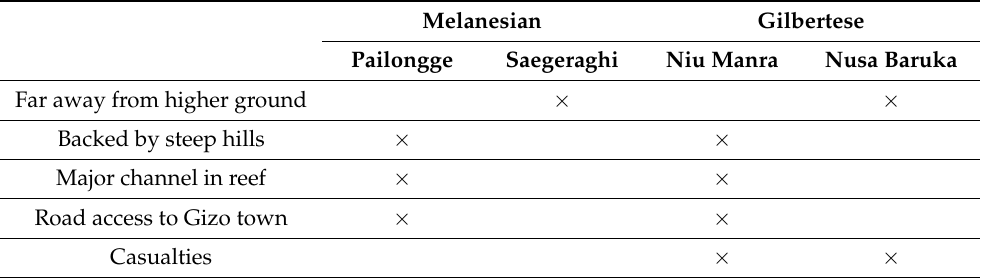
Table 3. Ethnic composition of studied Ghizo villages and villager perceptions of their village topographic setting.